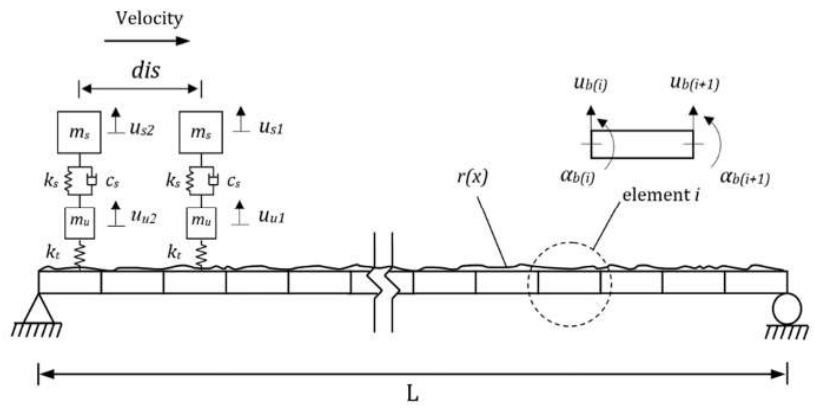
Figure 8. Two quarter-cars passing over the bridge.